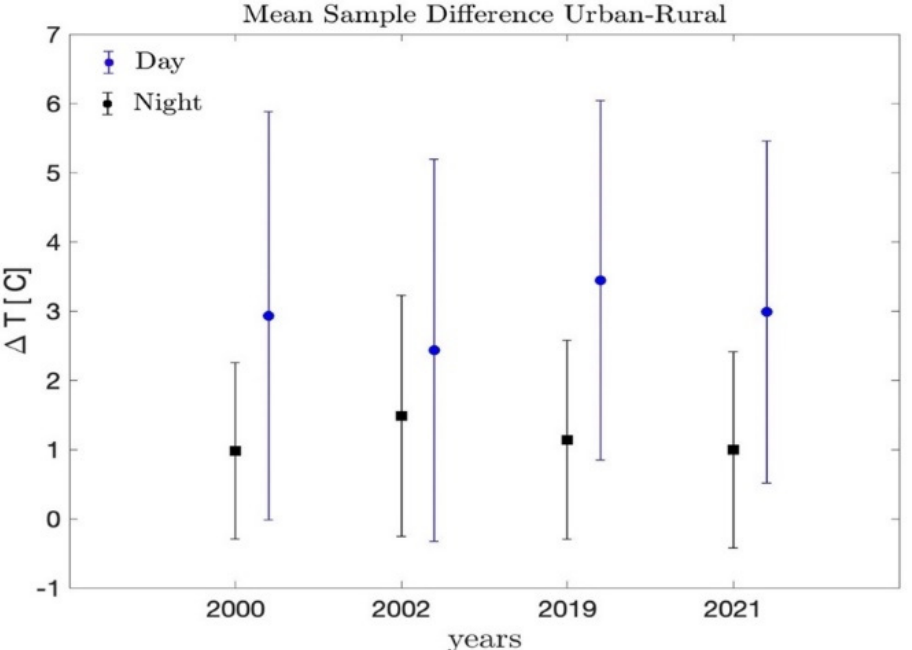
Figure 2. A comparison of SUHI intensity averaged over the subset of 28 cities during the 2021 HW and previous years without HW. Standard deviation of the mean value is represented by vertical error bars.